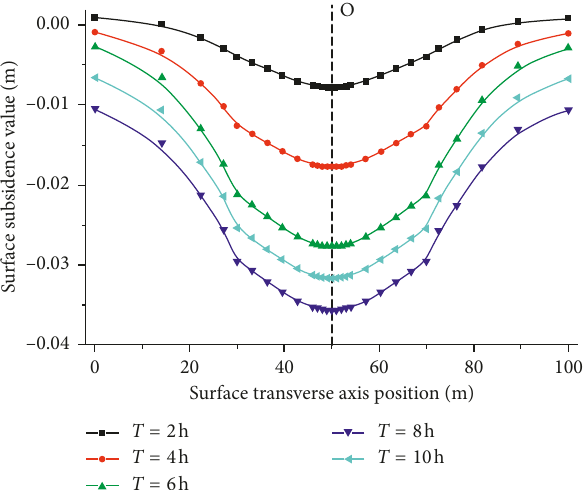
Figure 23: Surface subsidence tank at the reinforcement depth of H �